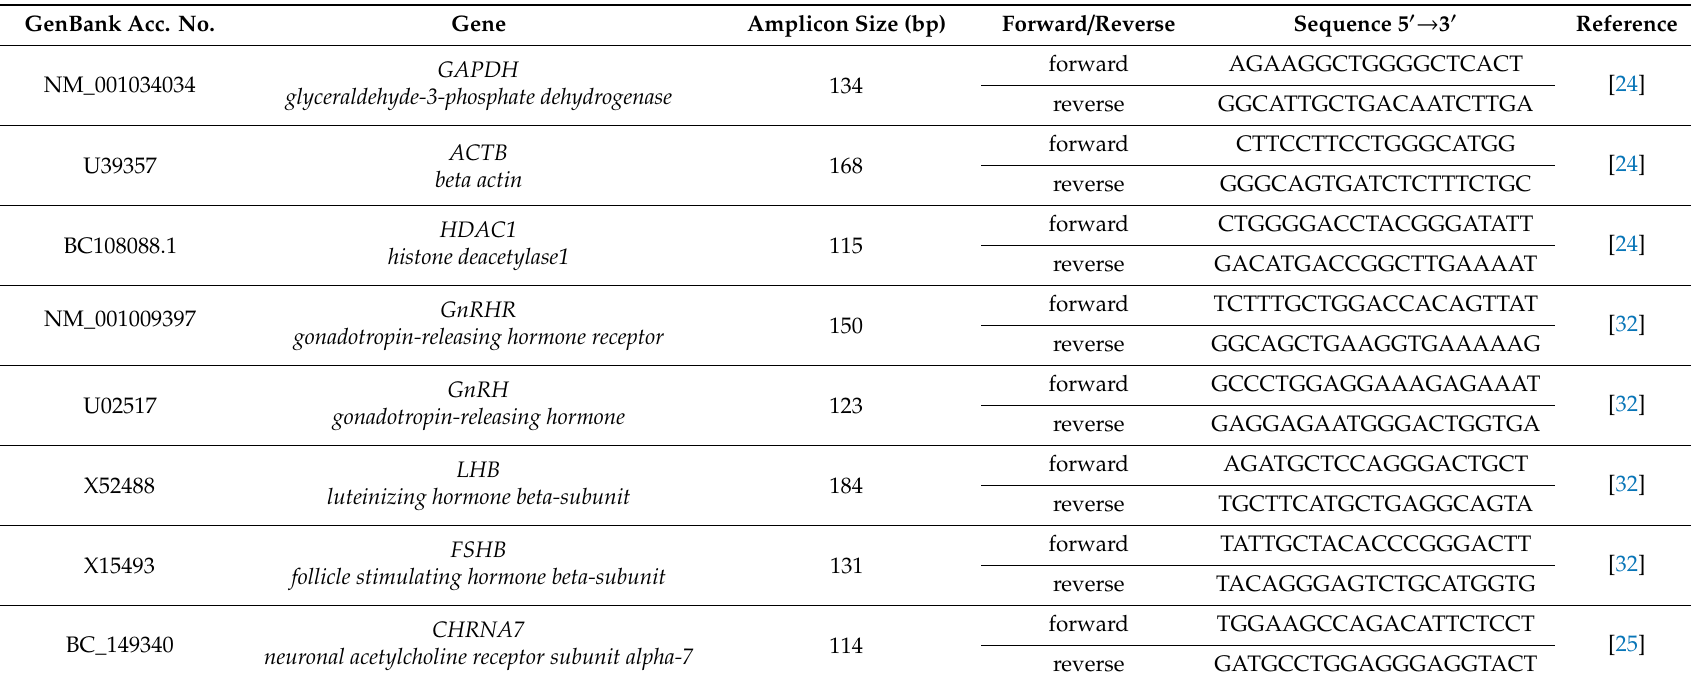
Table 5. List of full names and abbreviations of all genes analyzed by Real-Time